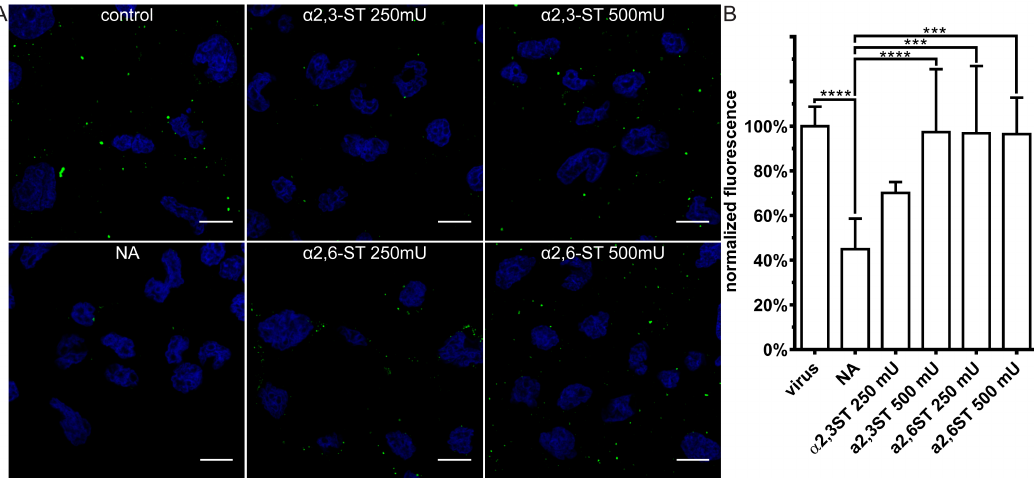
Figure 8. Resialylation restores HCoV-OC43 VR-1558 attachment to SAs-depleted cells. Cells treated with type II neuraminidase (NA, 500 mU/mL) and overlaid with α -2,3-sialyltransferase ( α 2,3-ST) or α -2,6-sialyltransferase ( α 2,6-ST) in the presence of 1 mM cytidine-5 (cid:48) -monophospho- N -acetylneuraminic acid for 2 h at 37 ◦ C. Next, cells were overlaid with iodixanol-concentrated HCoV-OC43 VR-1558, incubated for 2 h at 4 ◦ C, fixed, and immunostained. ( A ) Confocal analysis of HCoV-OC43 attachment in presence of NA and STs. Virions are presented in green, while blue denotes DNA. Scale bar 10 µ m. Data were collected from a minimum of 12 fields of view, from at least two different samples. ( B ) FACS analysis of viral attachment in presence of NA and STs. Graph shows median fluorescence normalized to control. All data is presented as mean ± SD from at least three experiments in triplicates. (* p < 0.05; ** p < 0.01; *** p < 0.001; **** p <